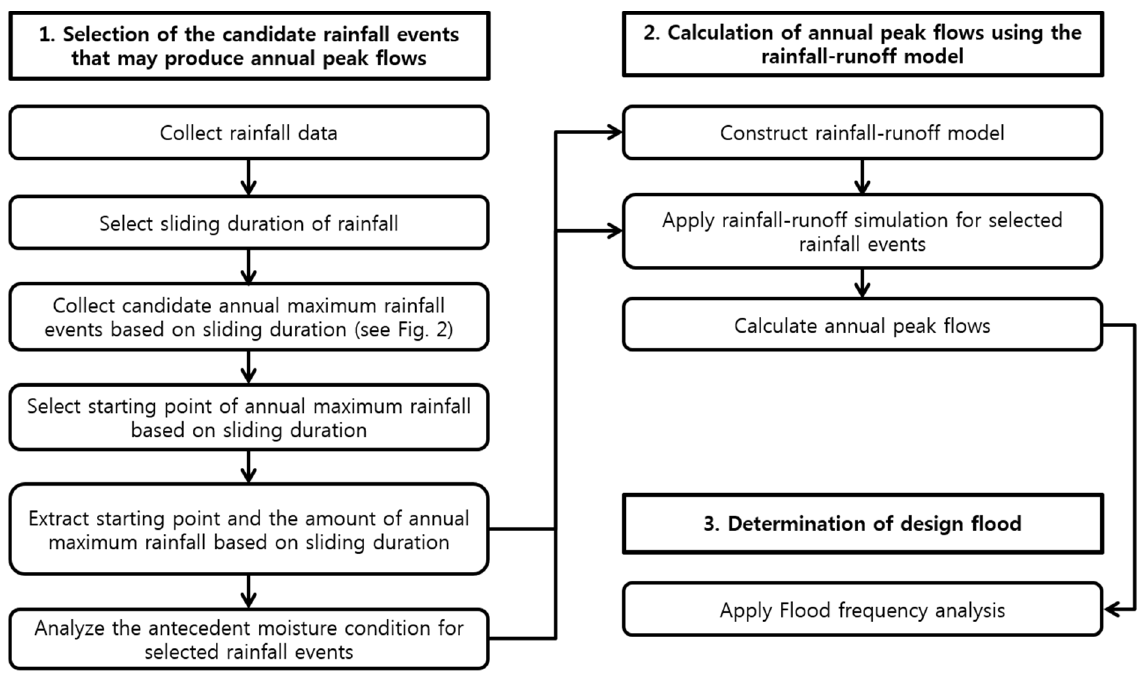
Figure 1. Flow chart for estimating annual peak